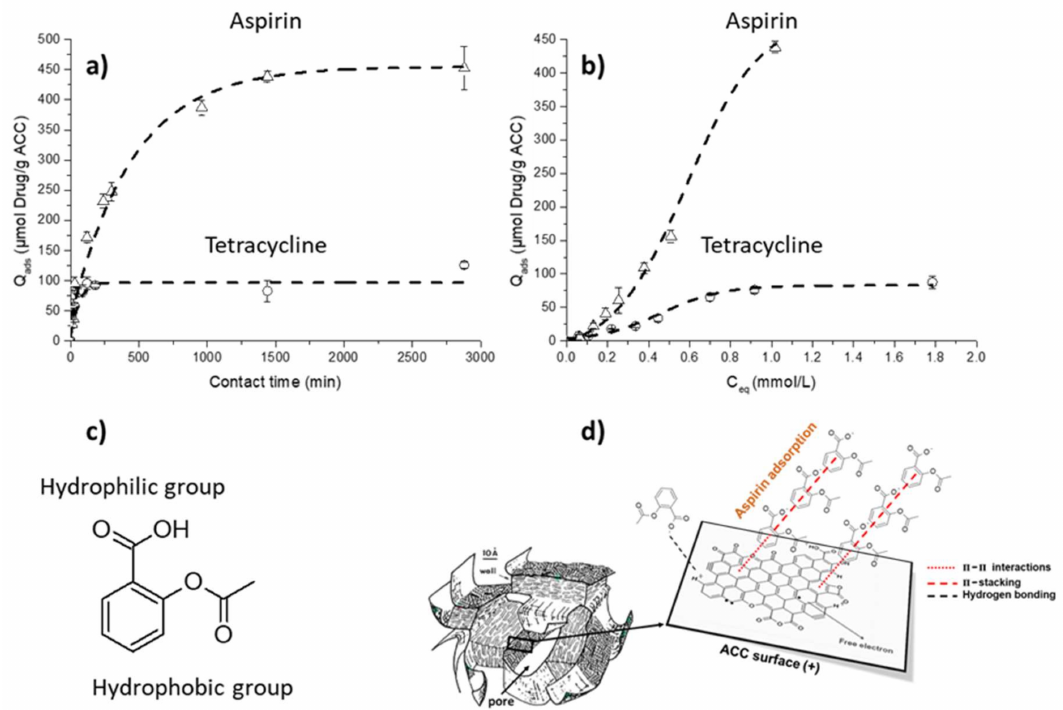
Figure 4. Drug adsorption on activated carbon fiber cloth using experimental protocol 2: ( a ) adsorption kinetics at pH = 7.4, room temperature and ( b ) adsorption isotherms at pH = 7.4, room temperature for 24 h; two drug adsorptions are performed with tetracycline (o) and aspirin ( ∆ ). ( c ) Chemical formula of aspirin, highlighting hydrophobic groups and ( d ) our proposed adsorption mechanism of aspirin at the surface of a porous carbon; model of carbon microtexture proposed by Villey et al. [64].